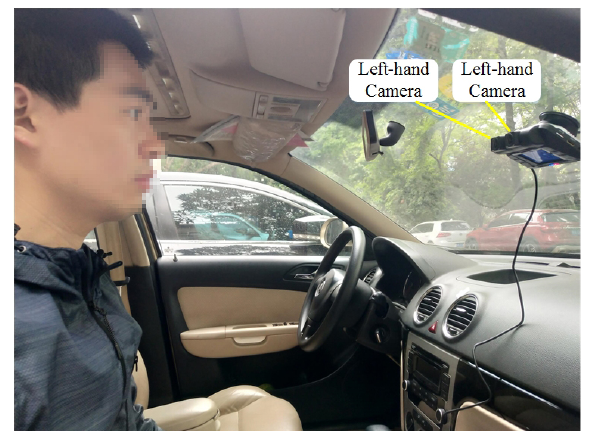
Figure 19. On-board image acquisition system (drive recorder).